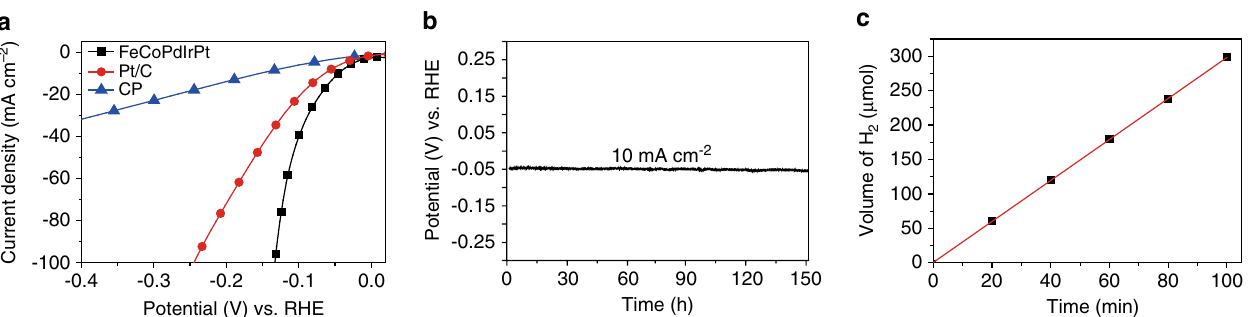
Fig. 7 Electrochemical HER performance of samples. a The activities toward HER of the prepared FeCoPdPtIr@GO and Pt/C, and pure CP eOur FMBP strategy allowslectrodes. Linear sweep voltammetry (LSV) curves were conducted to evaluate the activity toward HER at a scan rate of 5 mV s − 1 with iR correction. The mass loading of HEA-NPs on GO was 3 wt%. b Chronopotentiometry curve for FeCoPdIrPt@GO. c The amount of H 2 during